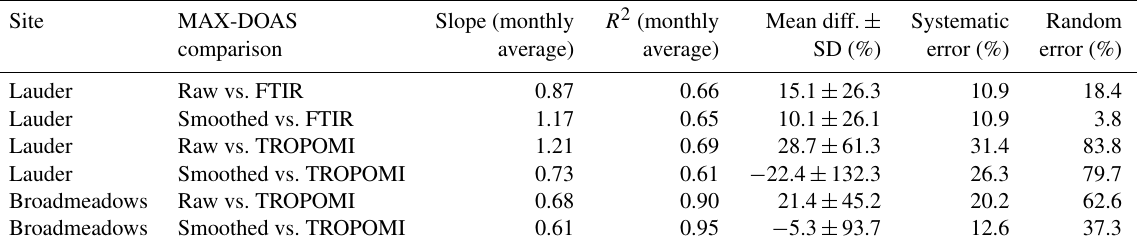
Table 2. Summary of MAX-DOAS formaldehyde results and error budget from Lauder and Broadmeadows. The slope and R 2 are from the linear regression fit to y = Slope × x + c , where y = FTIR or TROPOMI HCHO columns, and x = MAX-DOAS HCHO columns. The random and systematic error columns represent the breakdown of errors on the column differences. Percentages are with respect to the MAX-DOAS columns.